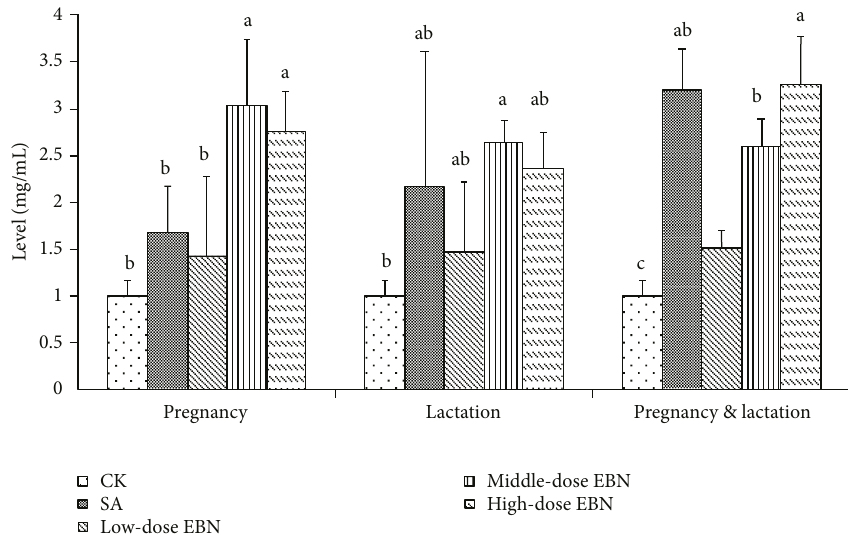
Figure 2: Comparison of free and oligosaccharide-binding sialic acid (FSA) level in mouse milk from each group of 10 female mice administrated with EBN. Signi fi cant di ff erences were indicated by di ff erent letters for each group ( P < 0 05 ).